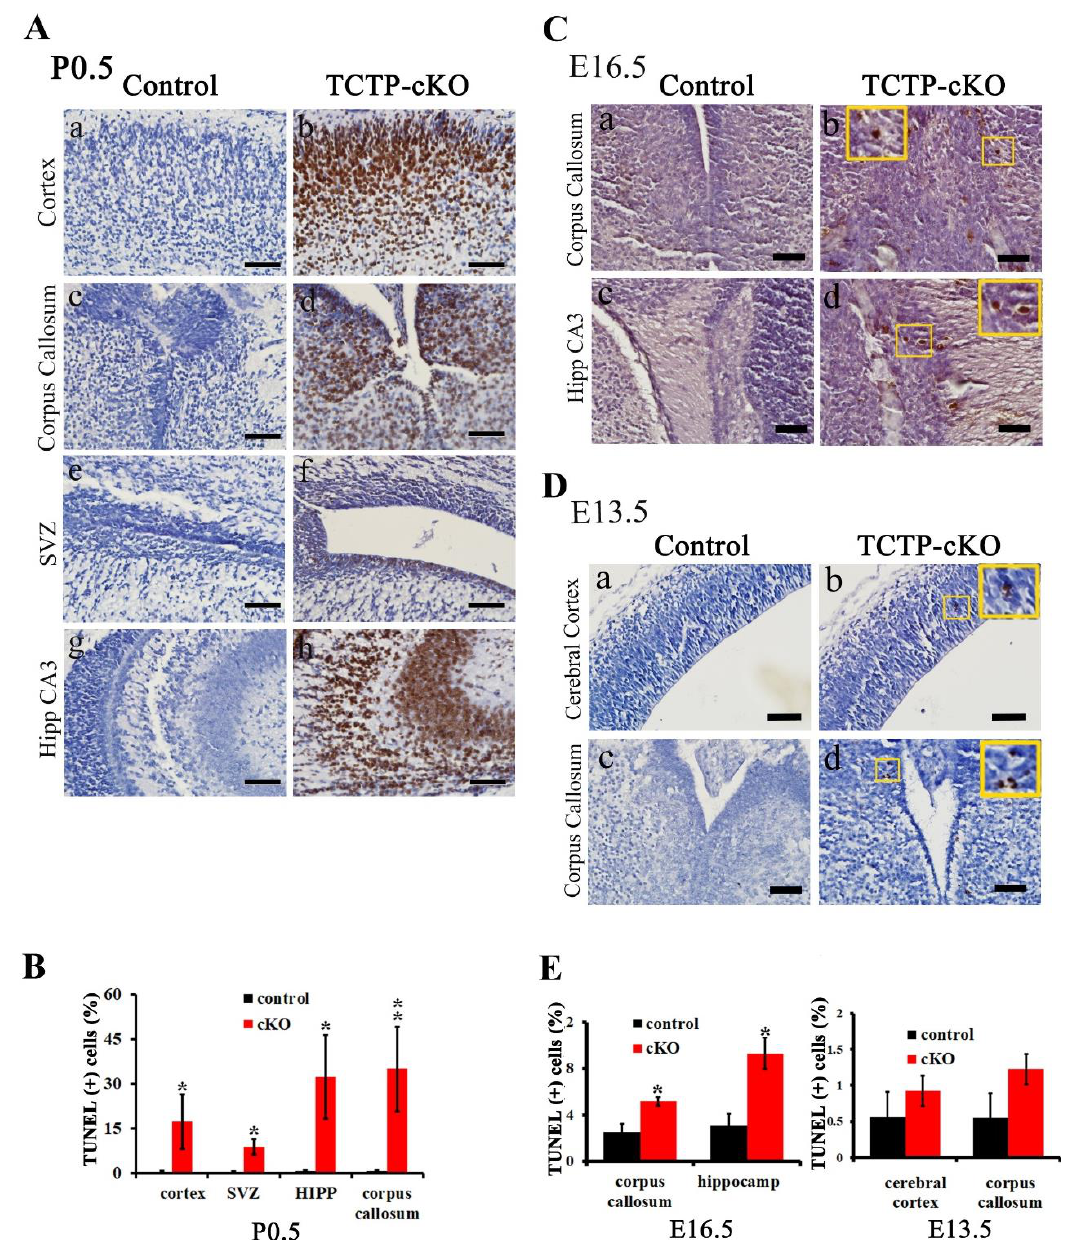
Figure 7. Cell apoptosis was detected in brain sections from control and cKO mice. ( A ) TUNEL staining was performed on coronal sections of the brain at P0.5, including the (a,b) hippocampus, (c,d) corpus callosum, (e,f) subventricular zone, and (g,h) hippocampus CA3. ( B ) Bar graph summarizing the quantification of TUNEL-positive (+) cells in ( A ). (Values are mean ± SEM, Student’s t test, * p < 0.05, ** p < 0.01 compared with control group; n = 3). ( C , D ) Apoptosis of brain sections from TCTP-cKO and control mice at E16.5 ( n = 3) and E13.5 ( n = 4) was also detected by TUNEL staining assay. Boxes indicate magnification. ( E ) Bar graph summarizing quantification of TUNEL-positive cells in ( C , D ). (Values are mean ± SEM, Student’s t test, * p < 0.05 compared with control group). Hipp, hippocampus; SVZ, subventricular zone. Scale bar: A, C, 40 µ m; D, 100 µ